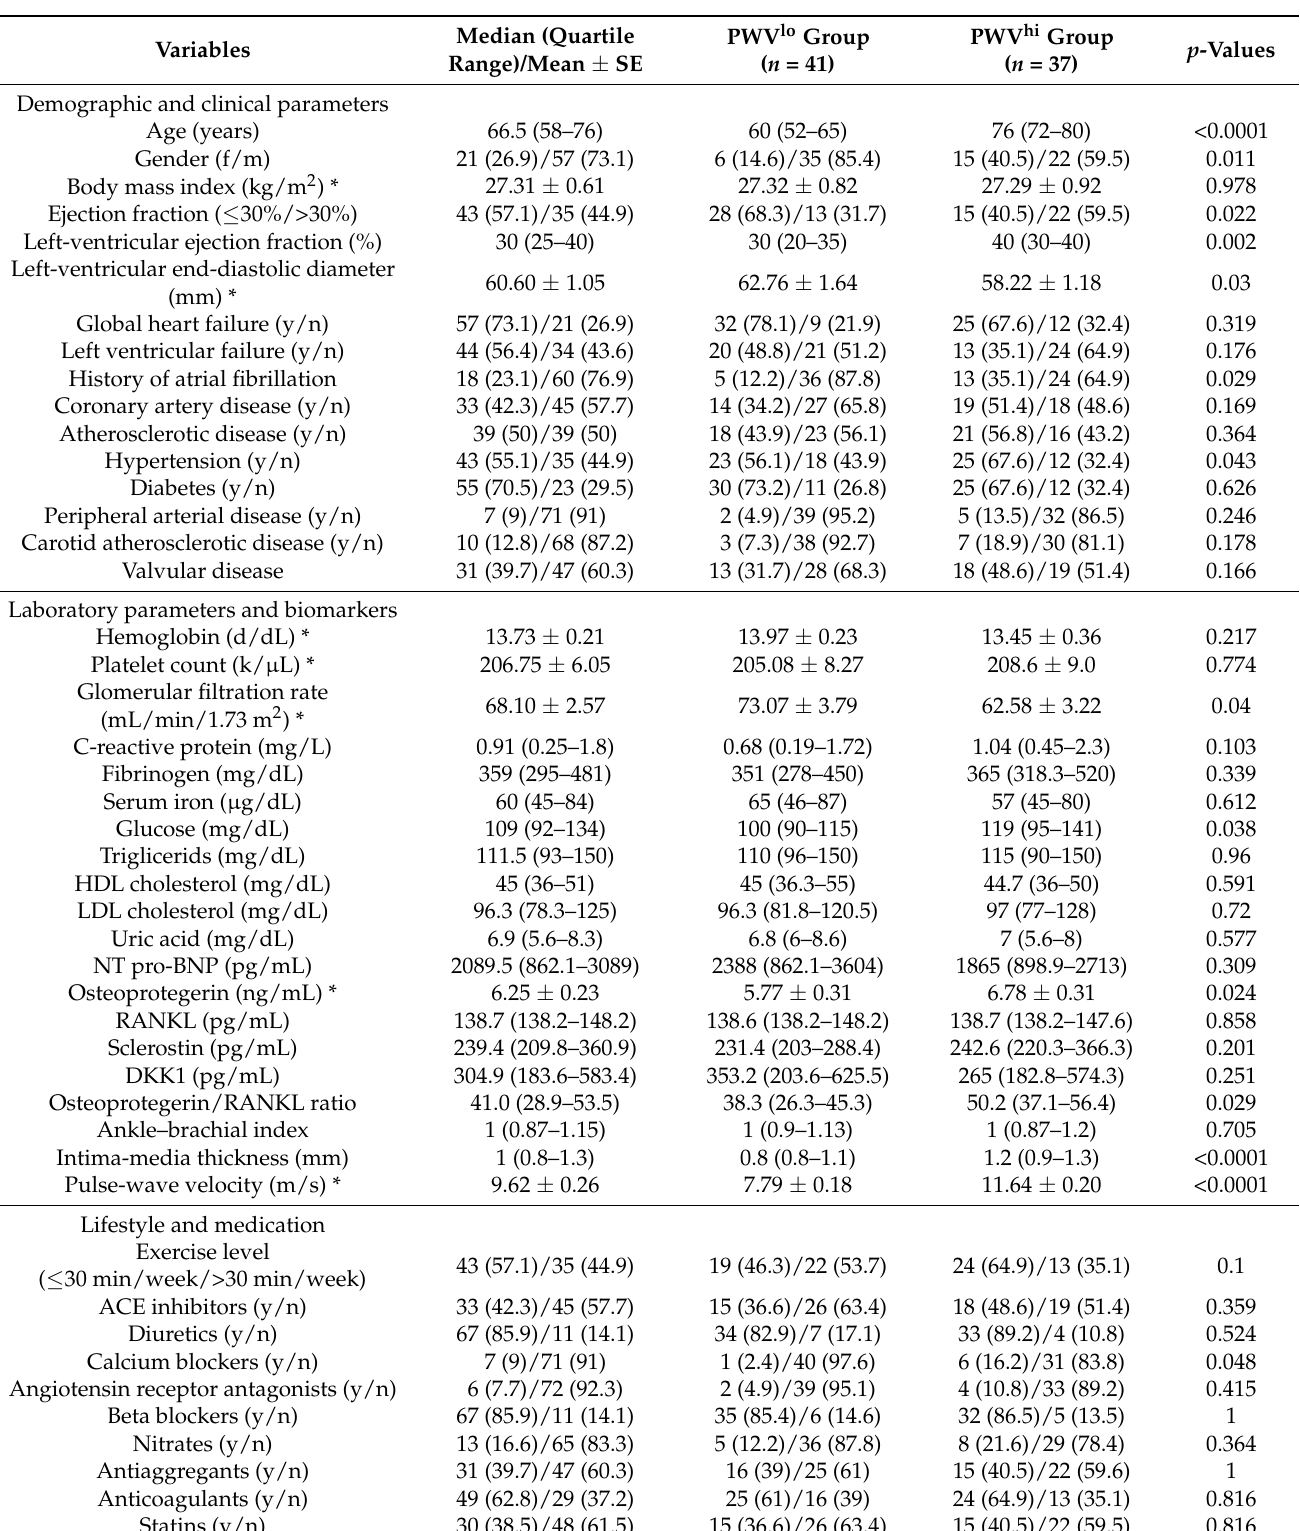
Table 1. Clinical and laboratory variables of the 78 HFrEF patients with low versus high arterial